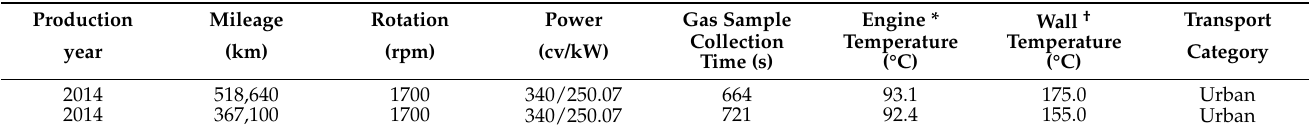
Table 1. Engine parameters and operating conditions along gas sampling. Steady state and working temperature similar to the on-load state—B340M.